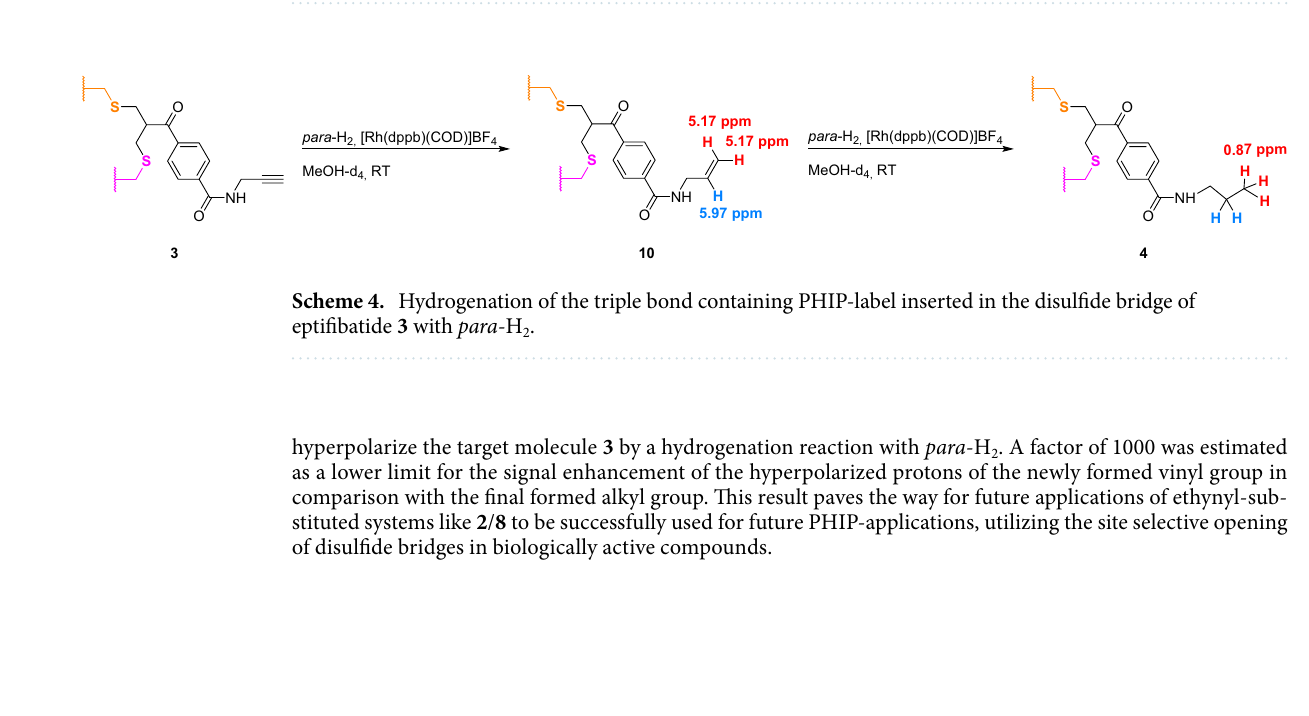
Figure 2. Relevant sections of the ESI–MS spectra recorded during the intercalation process as described in Scheme 3. [( a ) Eptifibatide, ( b ) Reduced eptifibatide, ( c ) Eptifibatide after label insertion, ( d ) intercalator 2 / 8 ].